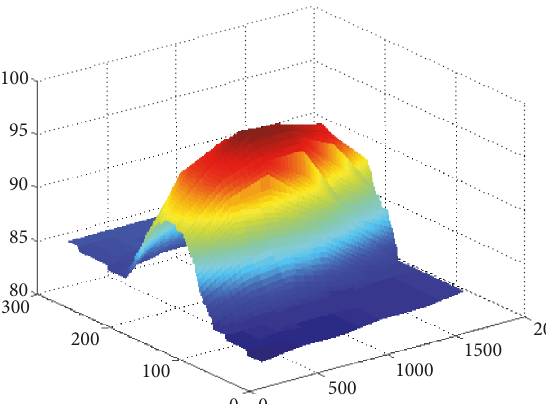
Figure 9: The results of the reconstruction after interpolation.